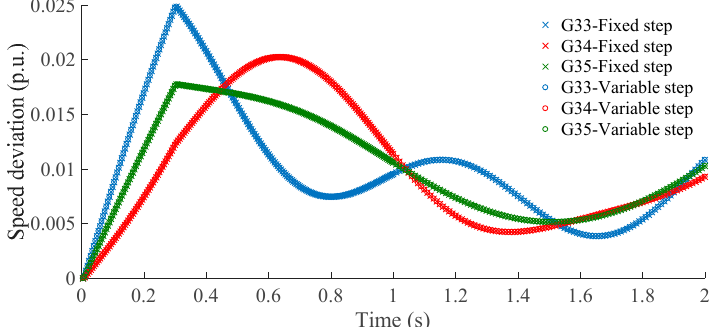
Figure 11. Rotor speed deviation of generators connected to nodes 33, 34 and 35 as provided by the solution of the TSCOPF when a short circuit at bus 16 using a fixed and variable integration time step.